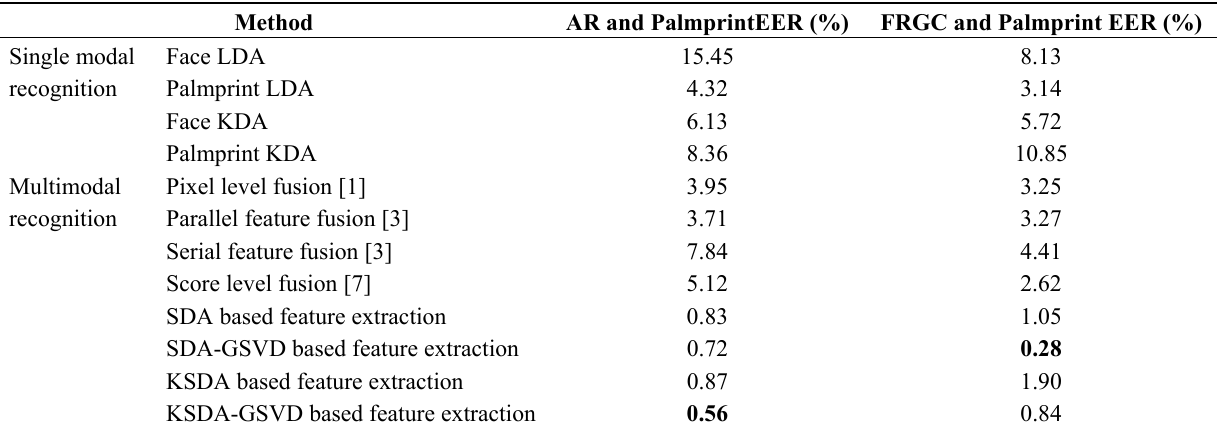
Table 3. The equal error rate (EER) of all compared methods on different databases. Method AR and PalmprintEER (%) FRGC and Palmprint EER